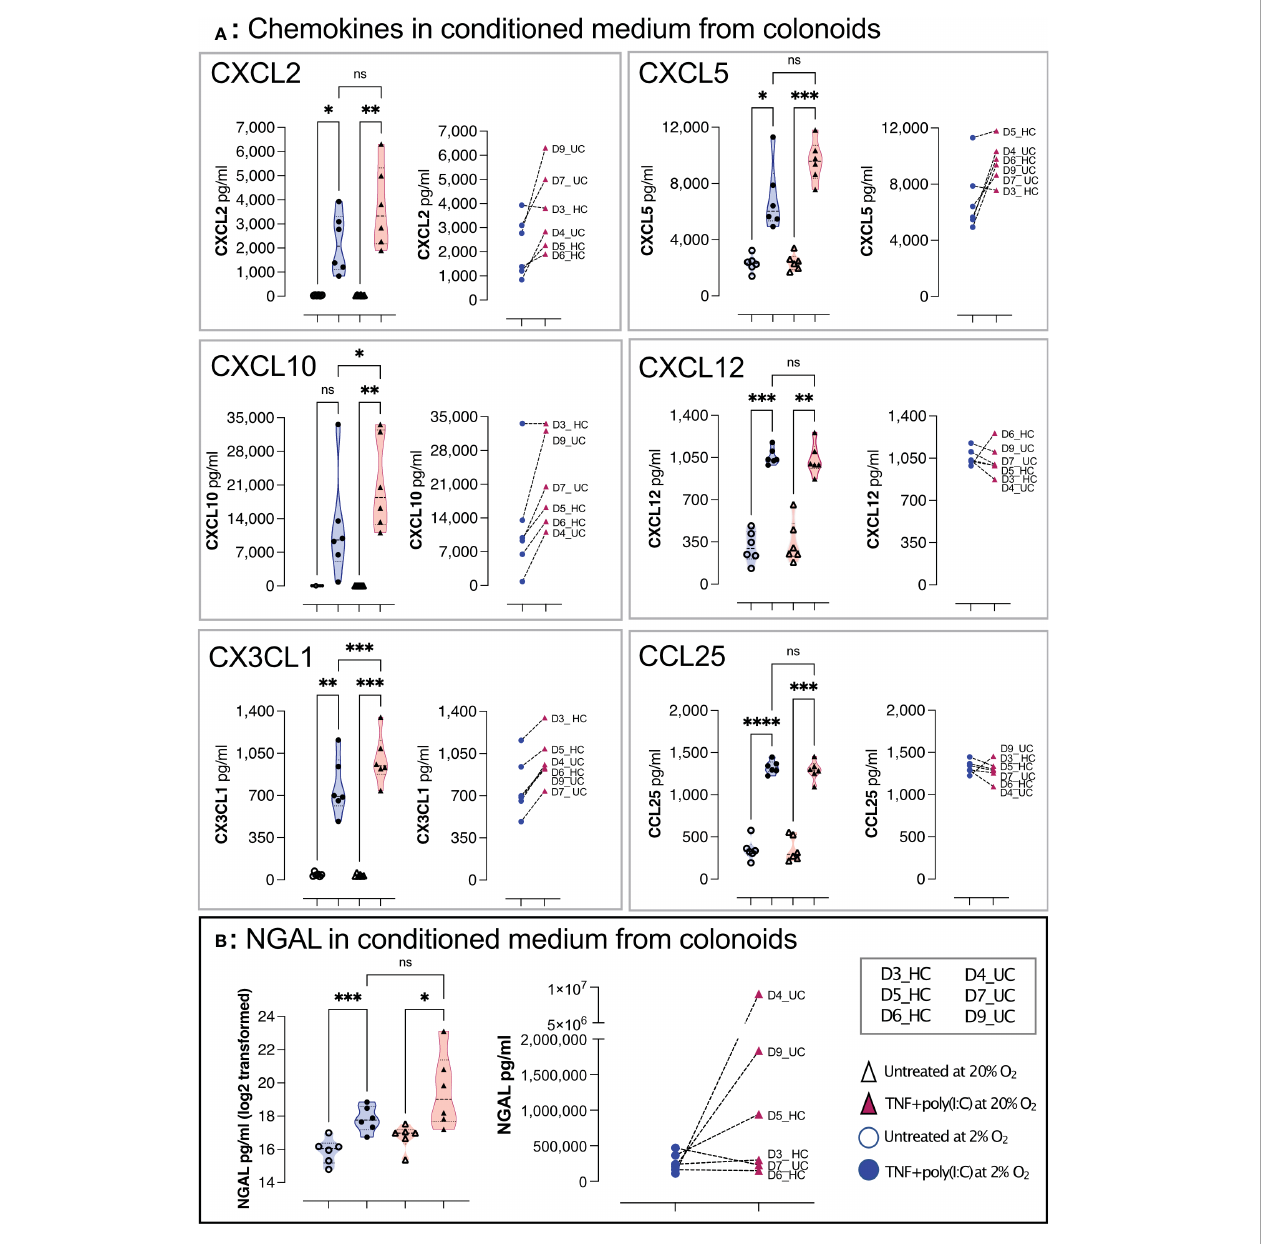
FIGURE 6 TNF+ Poly(I:C) induced chemokines and NGAL release from colonoids grown at high and low oxygen concentrations. Chemokines (A) and NGAL (B) in conditioned medium from differentiated untreated colonoids and after 24 hours of treatment with TNF + Poly(I:C). The treatment groups are represented on the x-axis, while the concentration of the target molecule is represented on the y-axis. In (A) , CXCL2, CXCL5, CXCL10, CXCL12, CX3CL1, and CCL25 concentrations (pg/mL) in conditioned medium were detected by Bio-plex Pro-Human Chemokine Panel analysis. In (B) NGAL was detected by ELISA. In each panel, the violin plots show the differences between untreated and TNF+Poly(I:C) treated colonoids cultivated at 2% oxygen (blue) and 20% oxygen (red). Each independent experimental replicate is plotted as individual values, and the graph to the right in each panel shows paired data for each donor treated with TNF+Poly(I:C) at 2% (blue circles) and 20% (red triangles). Statistical analyses were performed using RM one-way ANOVA followed by S ̌ ı ́ da ́ k ’ s multiple comparisons test. In left panel (B) , NGAL was plotted and analyzed on log2 transformed data. Right panel (B) shows paired NGAL concentrations as pg/ml for each donor. See Table 1 for colonoid donor characteristics * < 0.05, ** < 0.005, *** < 0.001, and **** < 0.0001. ns = non-signi fi